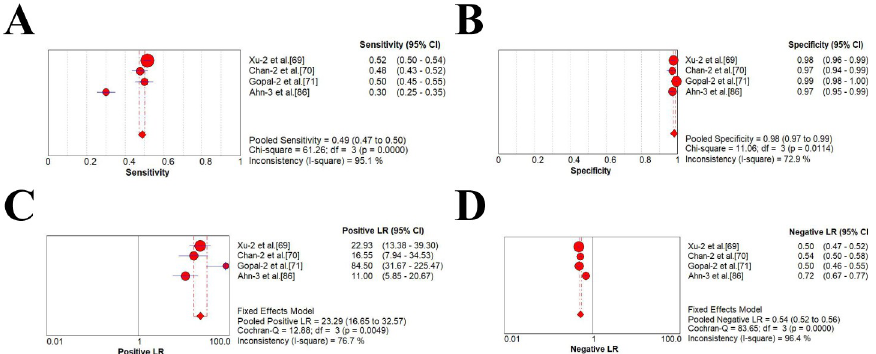
Fig 3. Forest plots of the estimates for AFP in HCC diagnosis (200 ng/mL). (A) Pooled sensitivity. (B) Pooled specificity. (C) Pooled positive LR. (D) Pooled negative LR.